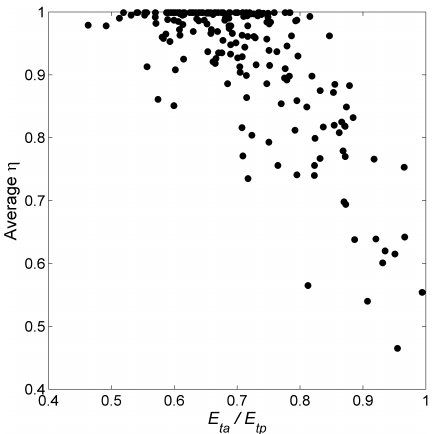
Figure 13. Scatterplots of mean η value and ratio of actual evapo- transpiration to potential evapotranspiration for 192 selected catch-